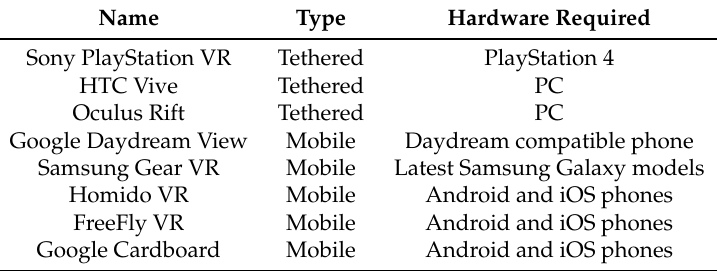
Table 4. Study of virtual reality (VR)